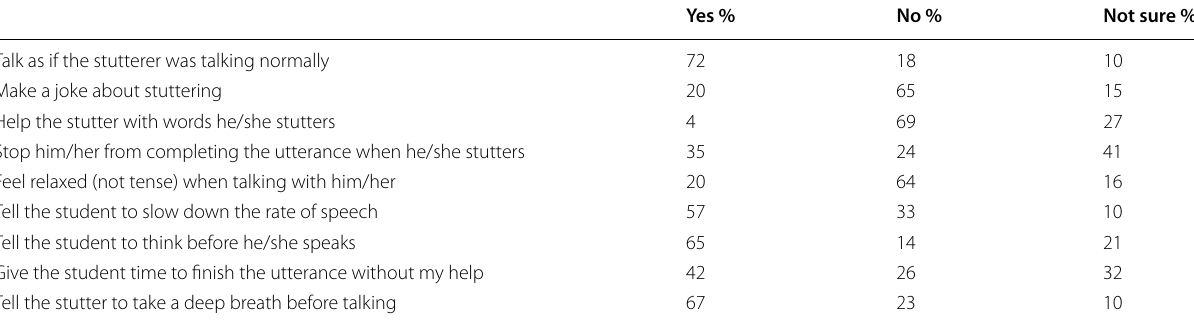
Table 5 Reaction of teachers when talking with a stutterer student